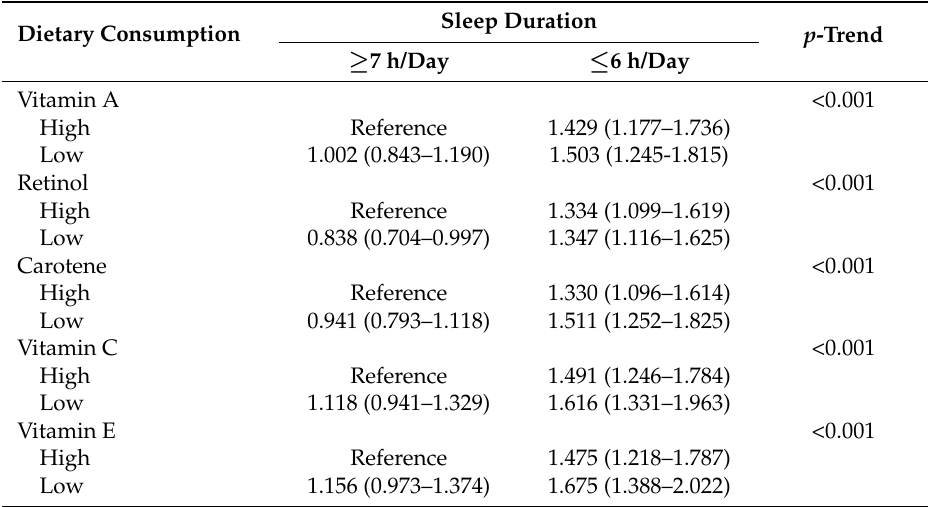
Table 4. Adjusted odds ratio for obesity according to dietary antioxidant consumption and sleep duration among Korean